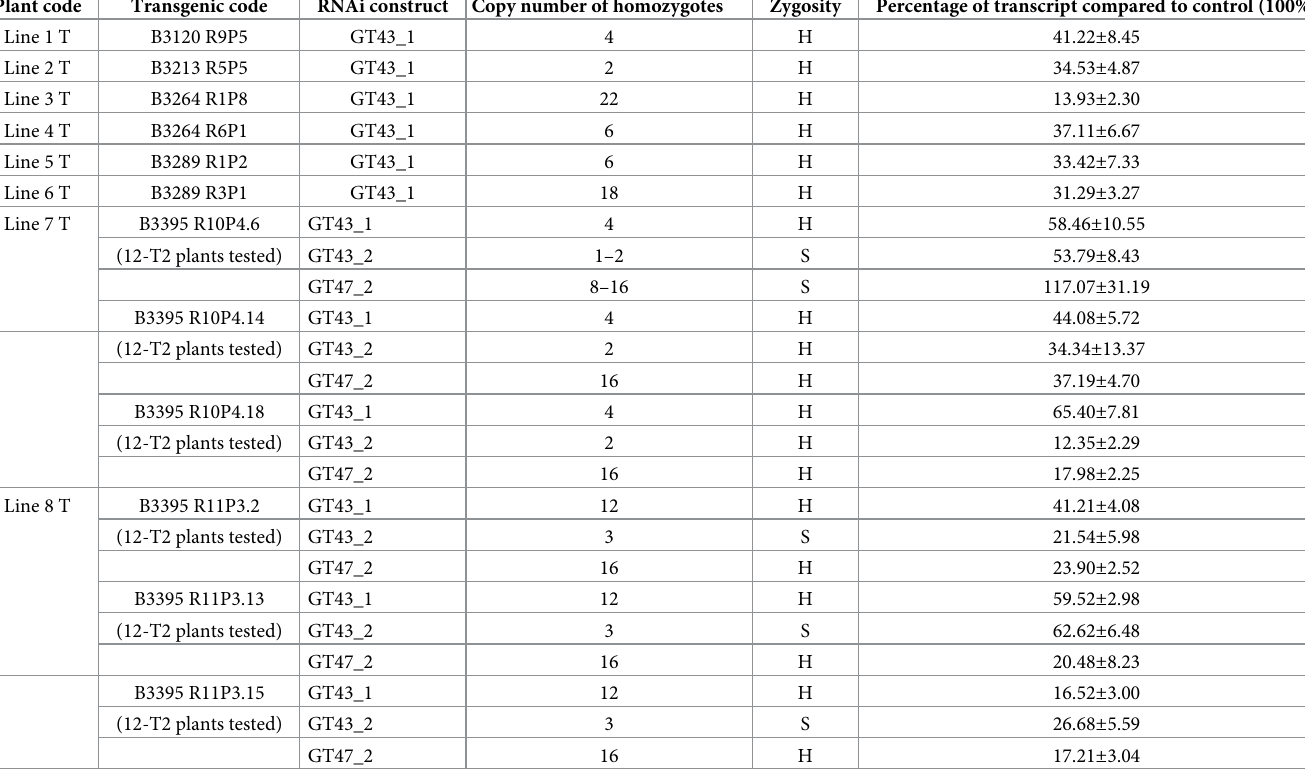
Table 1. Characteristics of GT43_1 single and GT43_1+GT43_2+GT47_2 Triple RNAi lines and control lines, including Plant code, Transgenic code, RNAi con- struct, Zygosity and differences compared to control data. Plant